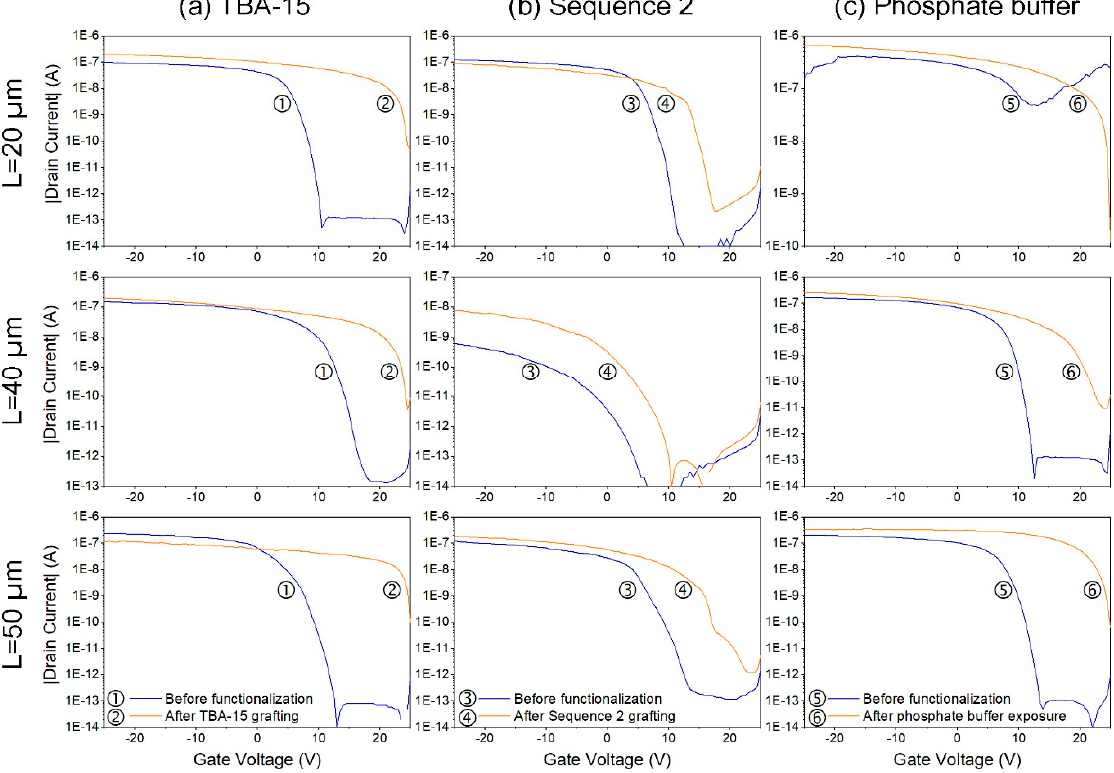
Figure 9. Impact of: ( a ) TBA–15 probe, ( b ) Sequence 2 probe and ( c ) grafting phosphate buffer on transfer characteristic for different channel geometries after 24 h of exposure in ambient conditions. The drain voltage V ds was set at − 2 V.